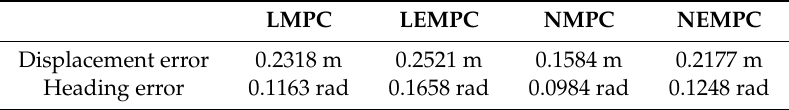
Table 7. The maximum absolute values with the positioning error in ± 0.1 m.